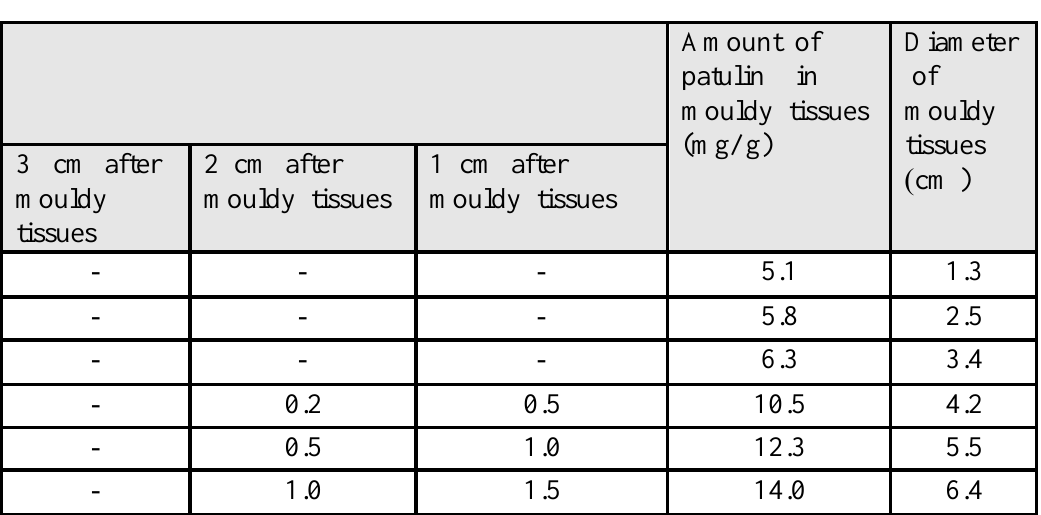
Table (1) : Amount of patulin mg/ g at healthy tissues surrounding mouldy tissues and the amount of patulin in moldy tissues and the diameter (cm) of moldy